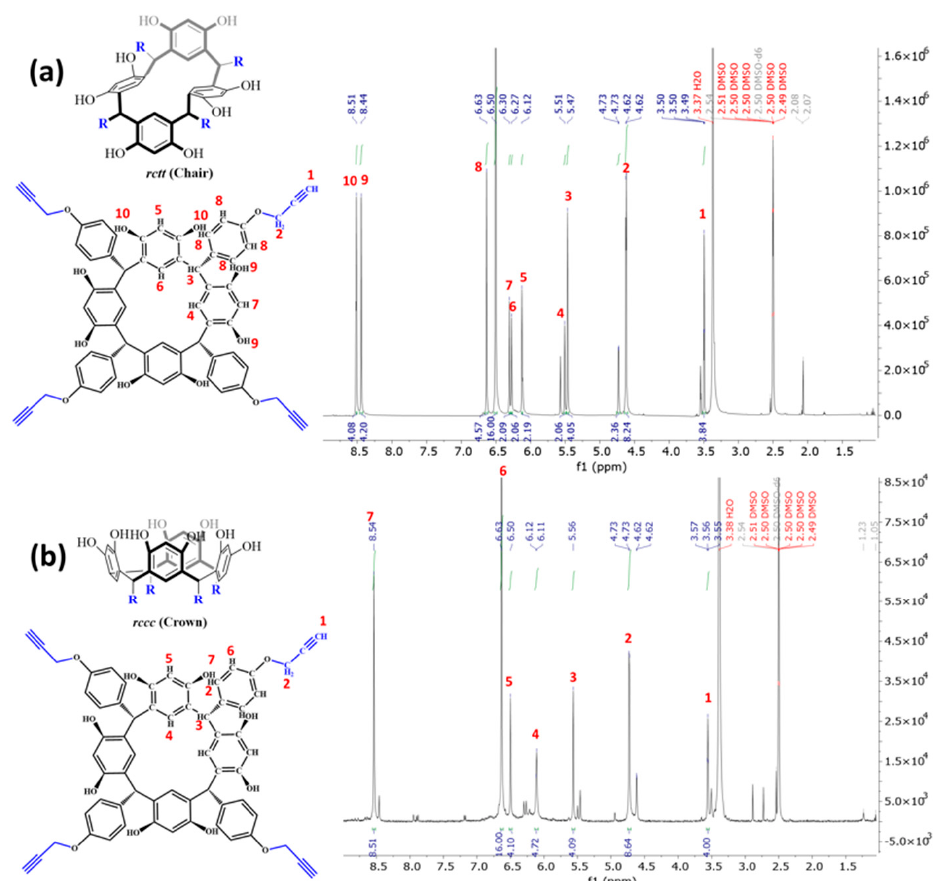
Figure 3. 1 H-RMN of ( a ) rctt conformer and ( b ) rccc conformer pure obtained in the synthesis of C - Tetra(4-(prop-2-yn-1-yloxy)phenyl)calix[4]resorcinarene.